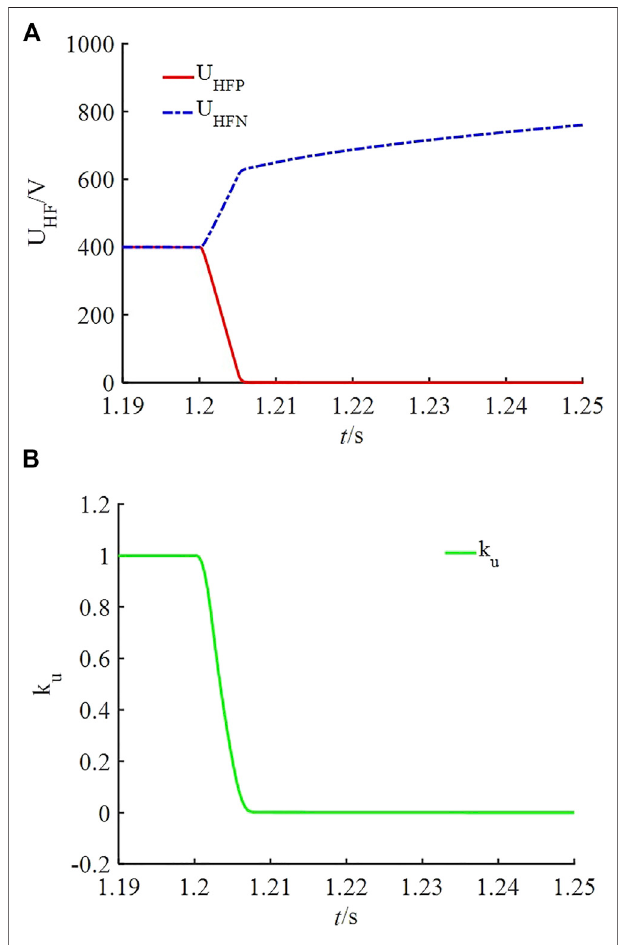
FIGURE 6 | Waveforms for Line2_5 positive pole-to-ground fault (A) U HFP and U HFN (B) k u .